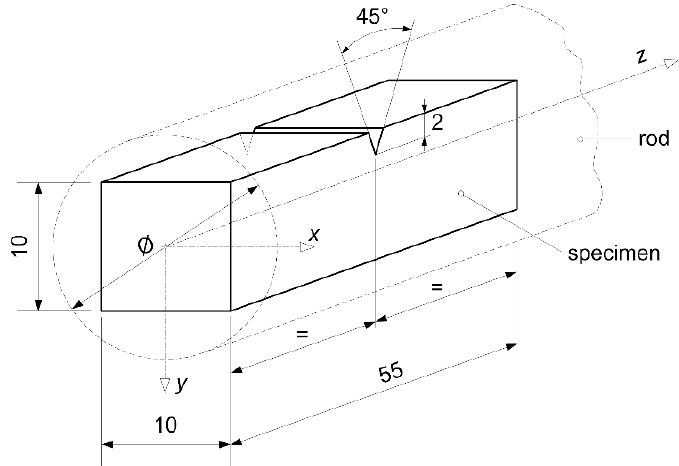
Figure 2. Charpy V-notch specimen (mm).